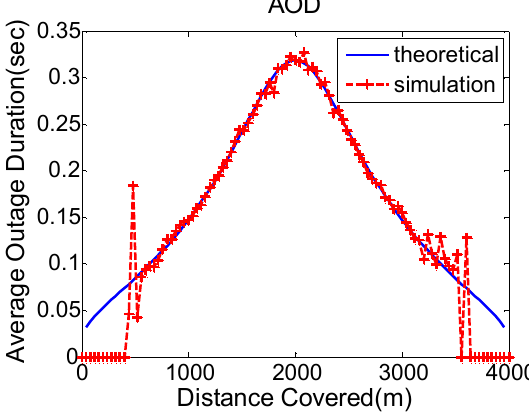
Figure 7. Theoretical and simulated average outage duration for a dual diversity scheme vs. distance covered.